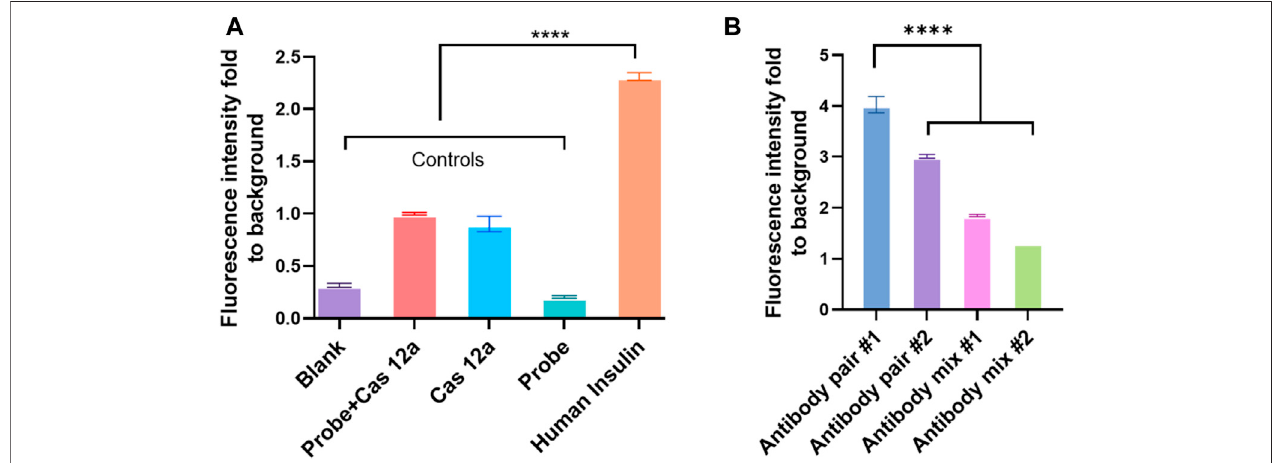
FIGURE4| Differentantibodypairsaffecttheef fi ciencyofCANi. (A) Detectionofhumaninsulinbyusingantibodypair#2( SupplementaryTableS3 ). (B) Different antibodypairsin fl uentthedetectionoftheanalytesbyCANi.Thecaptureantibodywasfrompair#1,andthedetectionantibodywasfrompair#2inantibodymix1.The captureantibodywasfrompair#2,andthedetectionantibodywasfrompair#1intheantibodymix2.****indicatessigni fi cantdifferences( p < 0.0001)analyzedbytwo- way ANOVA. Design of anti-IgG – ssDNA probe and guiding RNA.